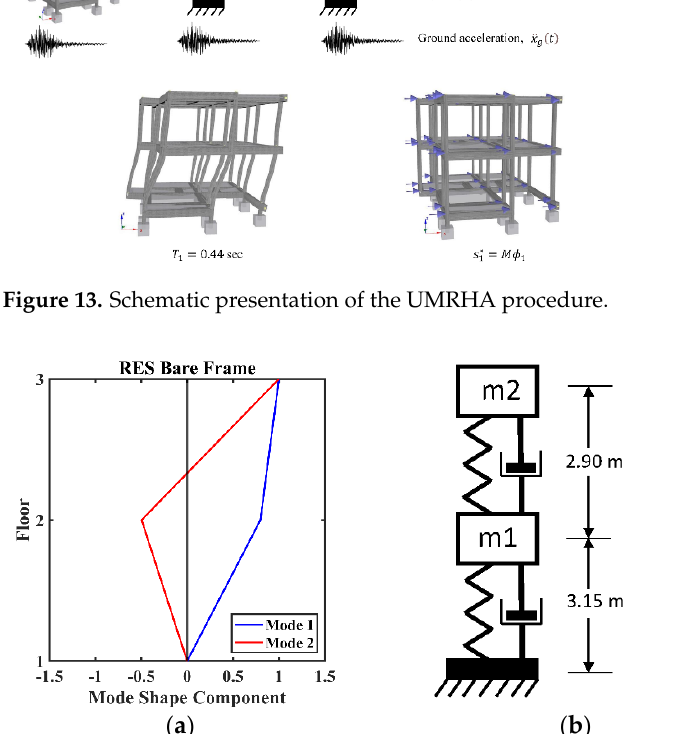
Figure 15. The hysteretic models of the RES bare frame versus the hysteretic response of idealized inelastic SDOF systems to three ground motions: ( a ) Imperial Valley; ( b ) Kobe; ( c ) Landers.